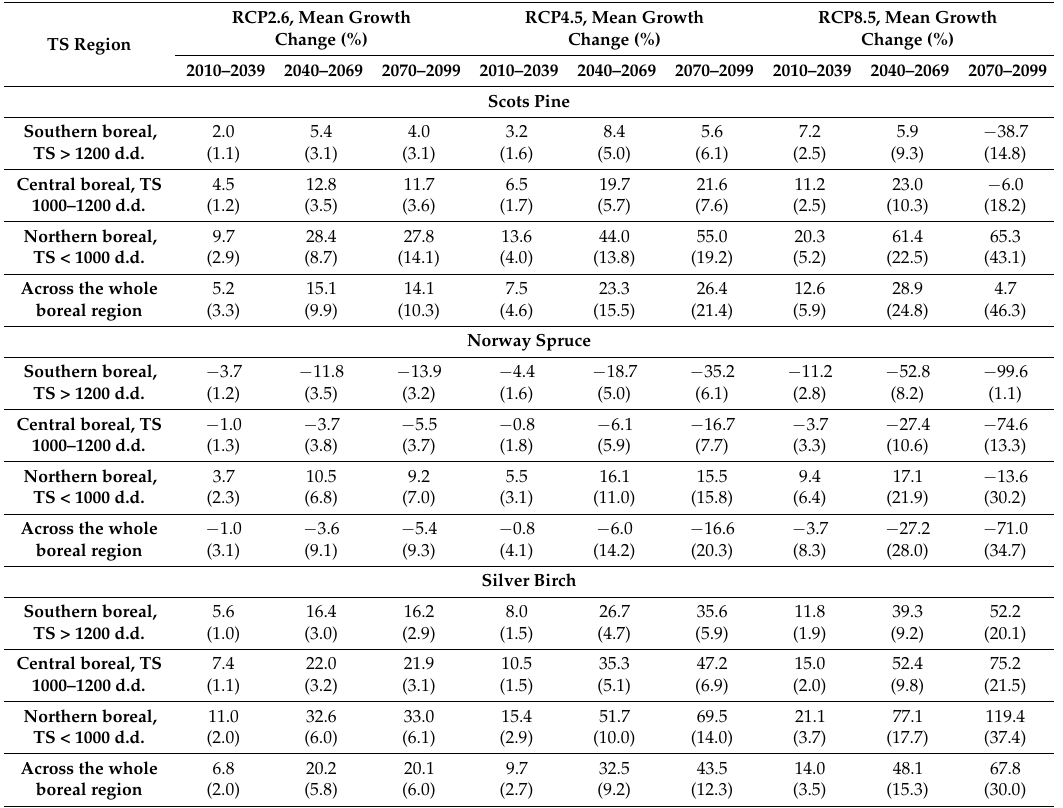
Table A4. Mean growth change (% of that under the current temperature sum) in Scots pine, Norway spruce, and birch, and across all tree species, for all upland forest sites (NFI11 plots, see Table 2) for the current temperature sum (TS) regions, under mild (RCP2.6), moderate (RCP4.5), and severe (RCP8.5) climate change scenarios, for each calculation period between 2010 and 2099. The numbers in parentheses indicate the standard deviation of growth change.